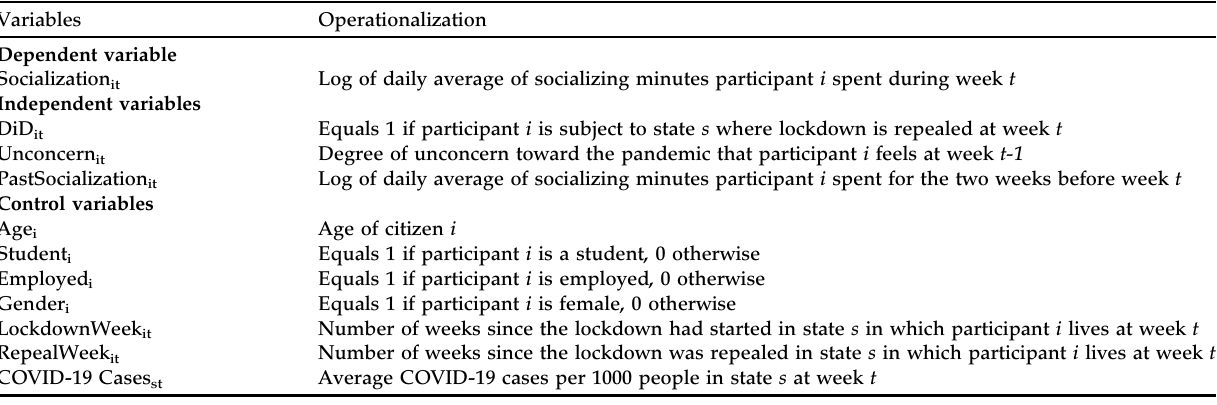
Table 3. Variable